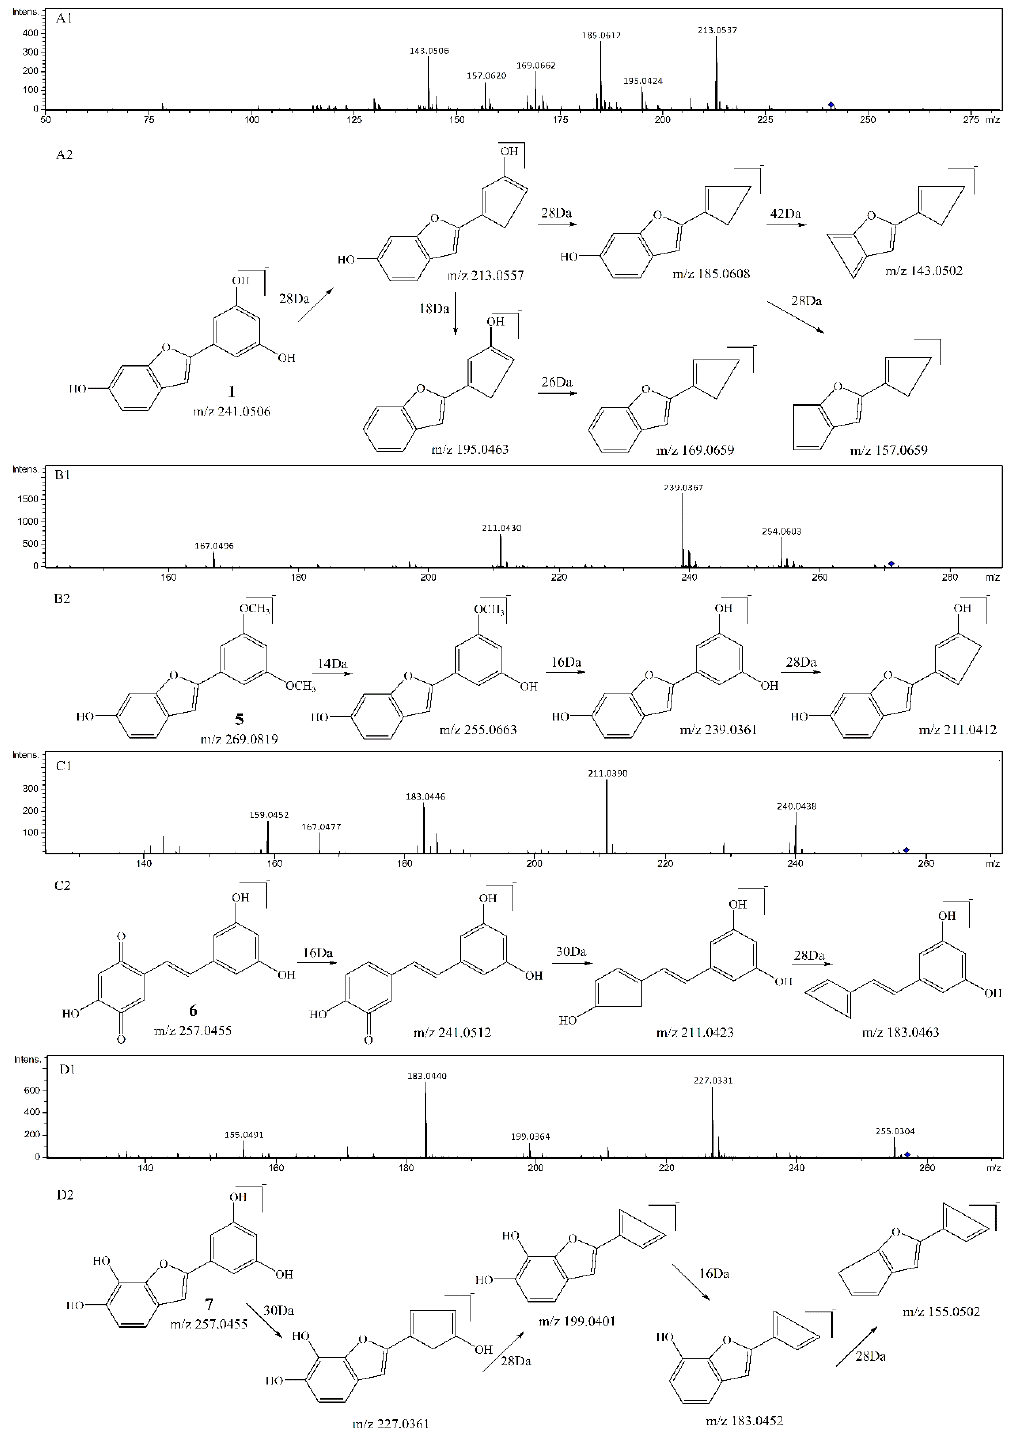
Figure 3. MS 2 spectrum of the precursor ion at m / z 241 ( A1 ) and its proposed fragmentation pathway ( A2 ). MS 2 spectrum of the precursor ion at m / z 269 ( B1 ) and its proposed fragmentation pathway ( B2 ). MS 2 spectrum of the precursor ion at m / z 257 a ( C1 ) and its proposed fragmentation pathway ( C2 ). MS 2 spectrum of the precursor ion at m / z 257 b ( D1 ) and its proposed fragmentation pathway ( D2 ). As compared with sample S2 (pterostilbene), the relative abundance of m / z 255.1036 in